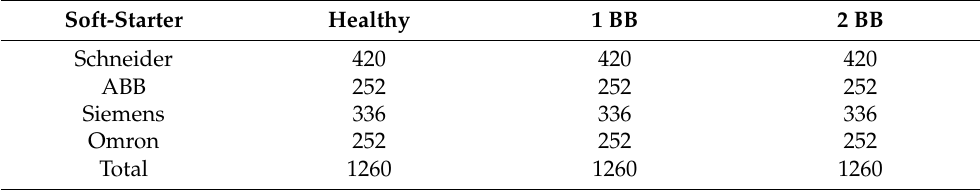
Table 1. Number of signals after data augmentation, including the original ones.